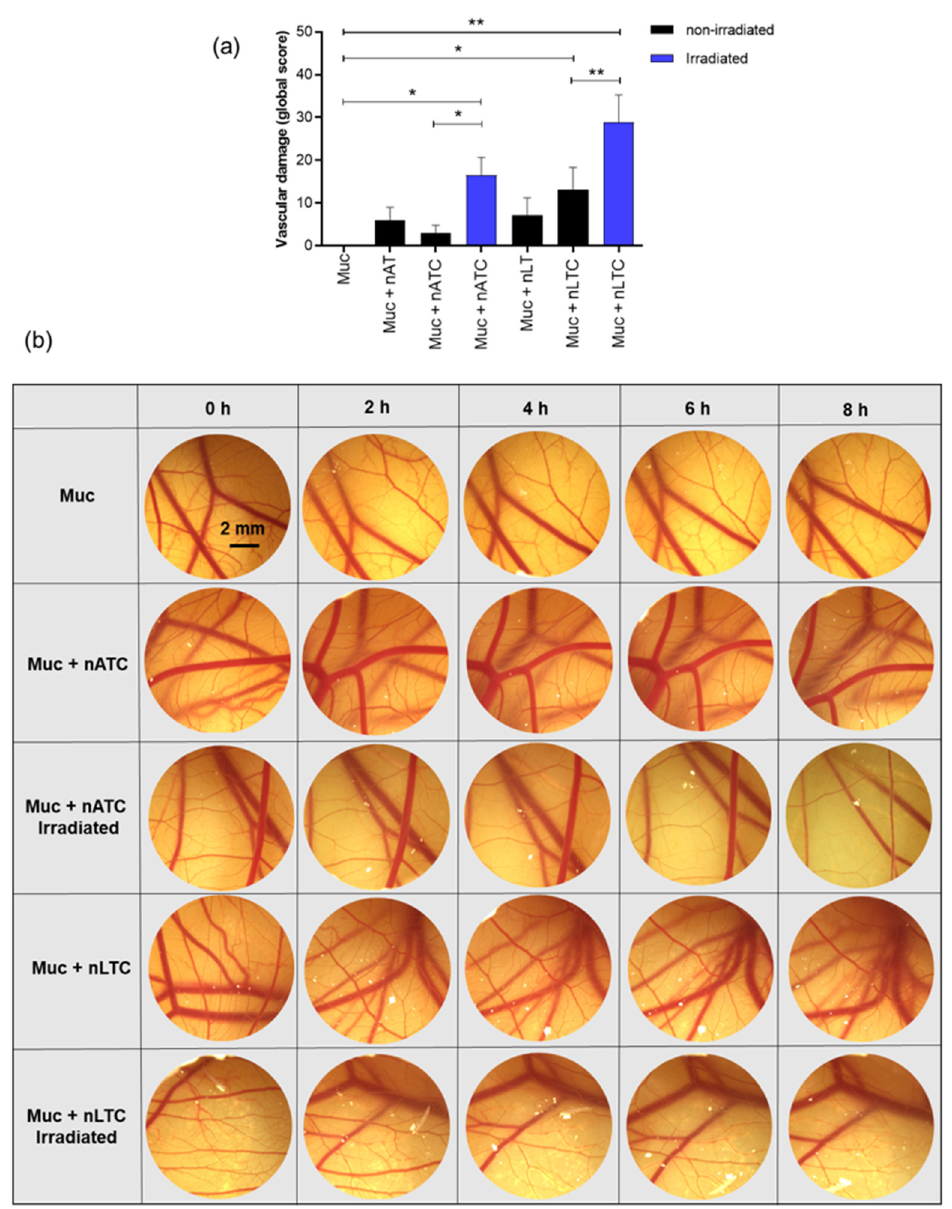
Figure 10. Vascular damage induced by nATC, nLTC, and free CUR on the CAM covered with mucins (Muc). ( a ) The global score of accumulated vascular damage after 8 h post-incubation with nATC, nLTC, or free CUR and irradiation with a fluence of 9 J/cm 2 or kept in the dark (non-irradiated). Statistical analyses were performed by Kruskal–Wallis non-parametric test followed by Dunn’s multiple comparisons. Differences were considered statistically significant at p < 0.05, * p = 0.0174, ** p = 0.0078. ( b ) Images of CAM vasculature at different time points after sample incubation